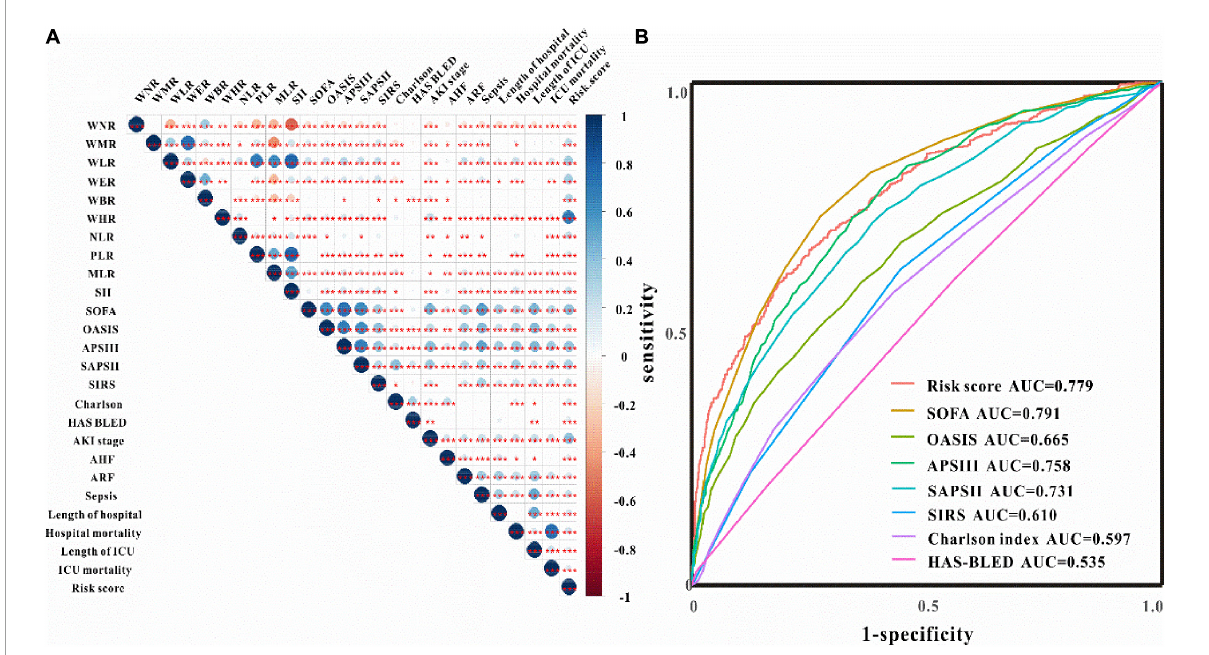
FIGURE2 Clinical correlation and predictive ability of WBC-related biomarkers. (A) The correlations between risk score with WBC-related biomarkers, severity score, and clinical outcomes. (B) ROC curves of risk score and severity score for the prediction of AKI among critically ill patients with IS.